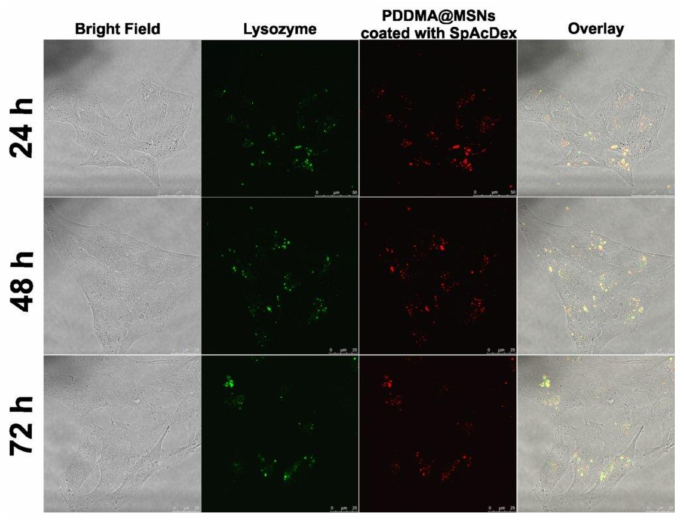
Figure 6. The cellular uptake of lysozyme-loaded (green) SpAcDEX-coated PDDMA@MSNs (red) incubated with HeLa cells at 24 h, 48 h, and 72